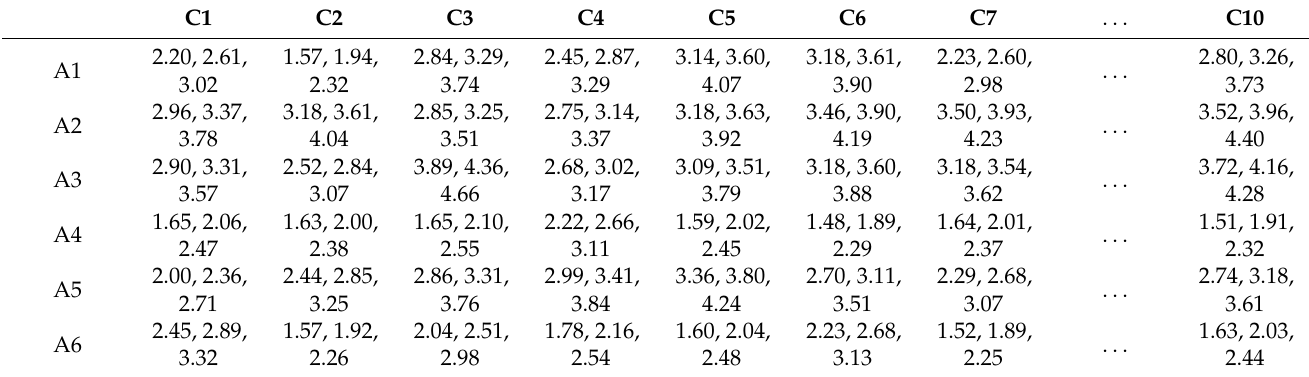
Table 8. Initial fuzzy decision